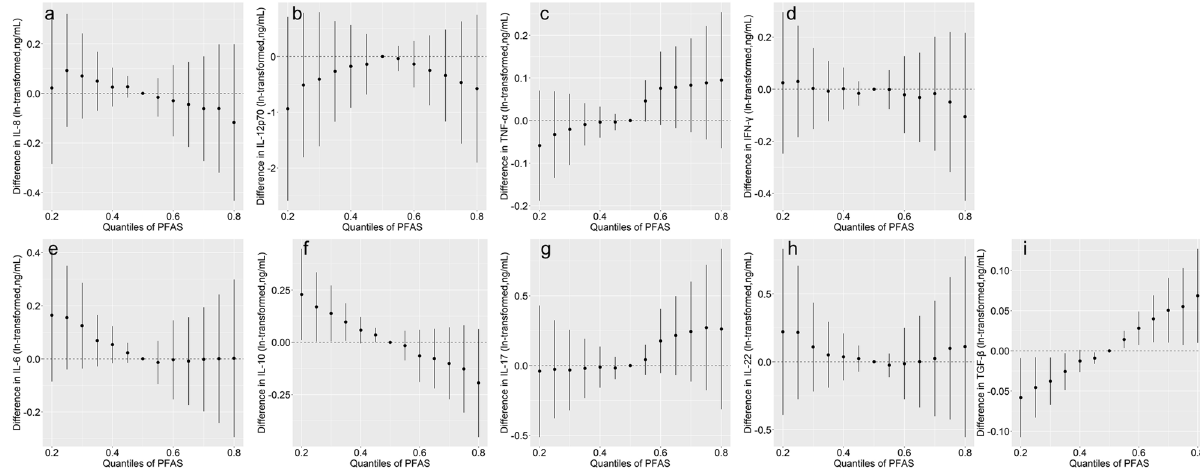
Figure 2. Combined effects of PFAS mixture on changes in ln-cytokines were estimated by Bayesian Kernel Machine Regression (BKMR) model when all PFAS were fixed at a specific percentile compared to when all of them were fixed at the 50th percentile. Models were adjusted for age, BMI, menarche, and